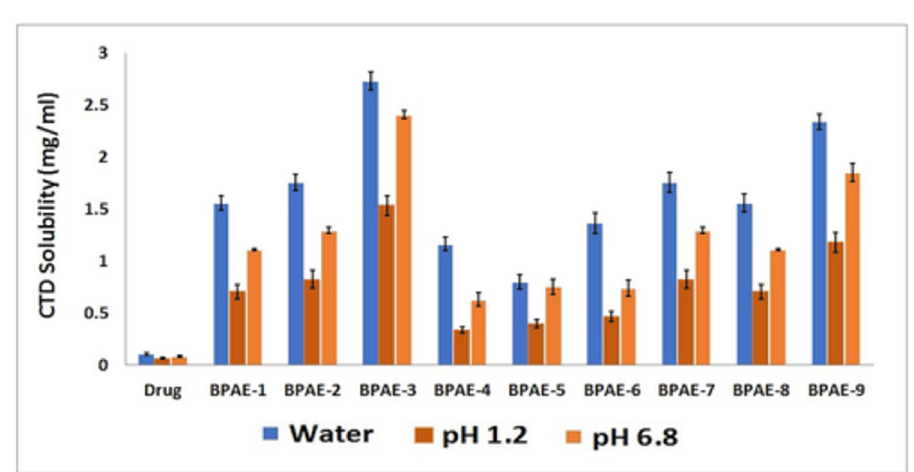
Fig 6. Comparative solubilization (%) of Rosuvastatin in pure form and developed β CD/PVP-co-poly (AMPS) nanogels in distilled water (highest solubility), phosphate buffer of pH 6.8 (high solubility) and HCl buffer of pH 1.2 (low